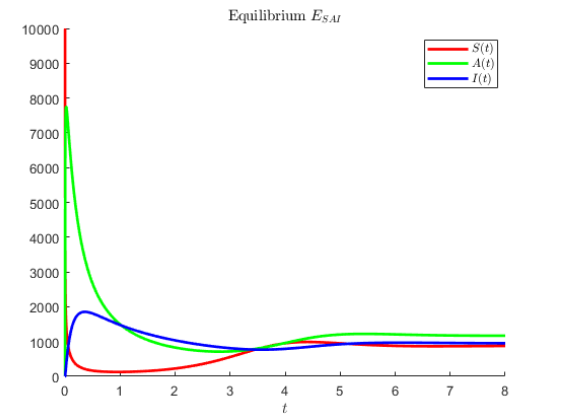
Figure 5. Coexistence equilibrium for model (23) obtained with parameter values (56), (51) and initial conditions (50).